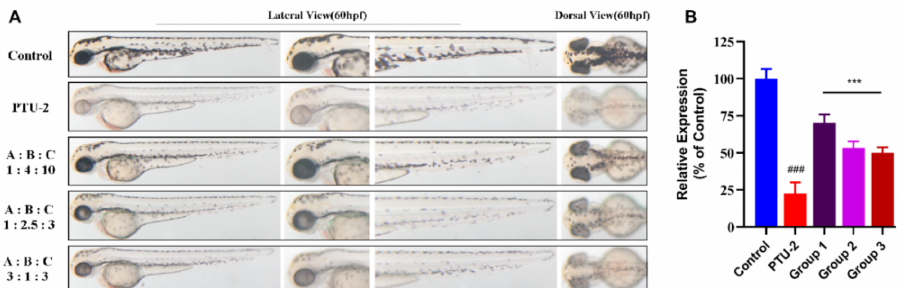
Figure 10. Validation of mathematical model of drug combination. ( A ) Zebrafish melanin phenotype in various ratio of compounds (butin-A, caffeic acid-B, and luteolin-C). Each combination group is equal in concentration (100 µ M). ( B ) Collecting zebrafish in each group for testing relative expression (% of control). Group 1, 2 and 3 mean ratio (1:4:10, 1:2.5:3 and 3:1:3) groups. Results shown are mean ± SEM. Data were analyzed by ANOVA followed by post hoc Tukey test. n = 30 zebrafish,